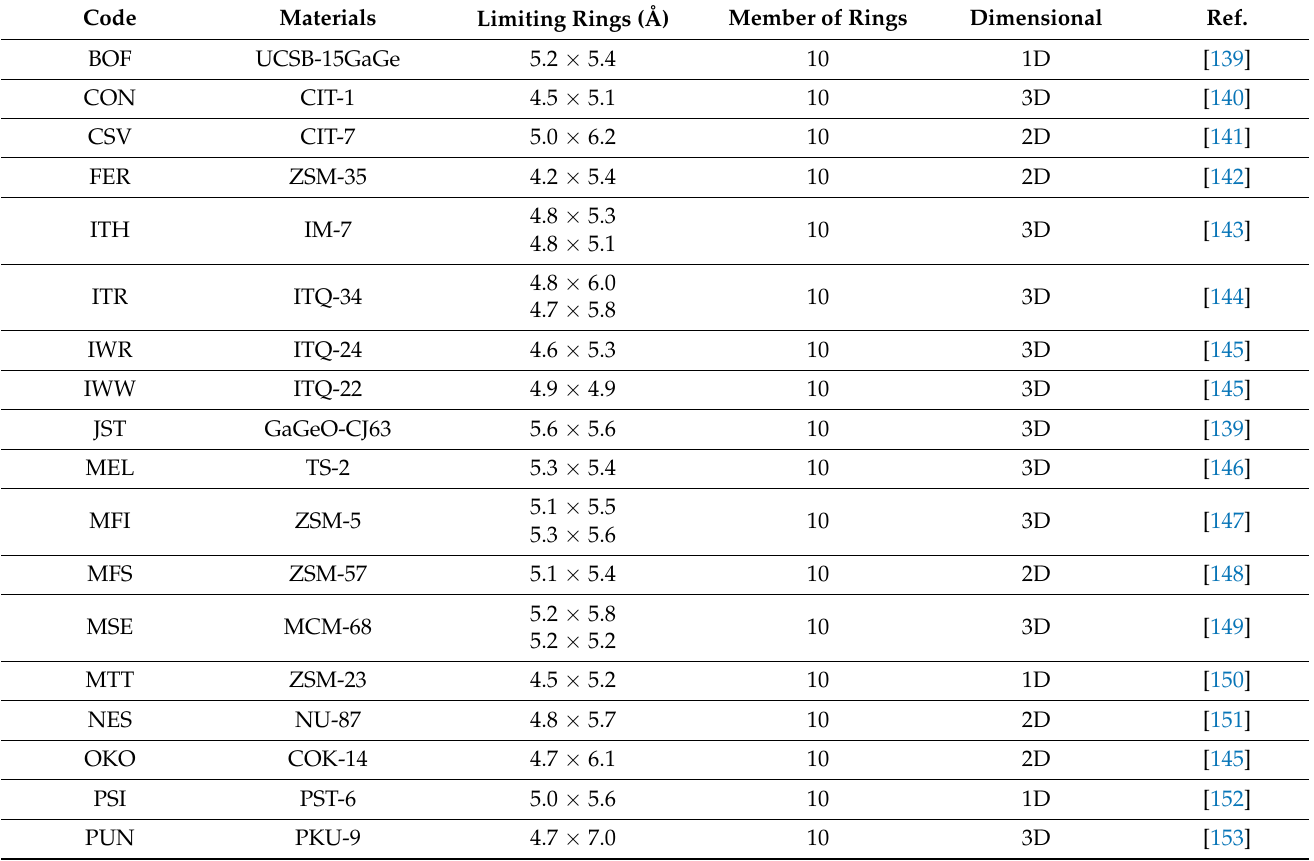
Table 15. Type of zeolites materials with their corresponding limiting rings, ring members, and dimensional. Code Materials Limiting Rings (Å) Member of Rings Dimensional